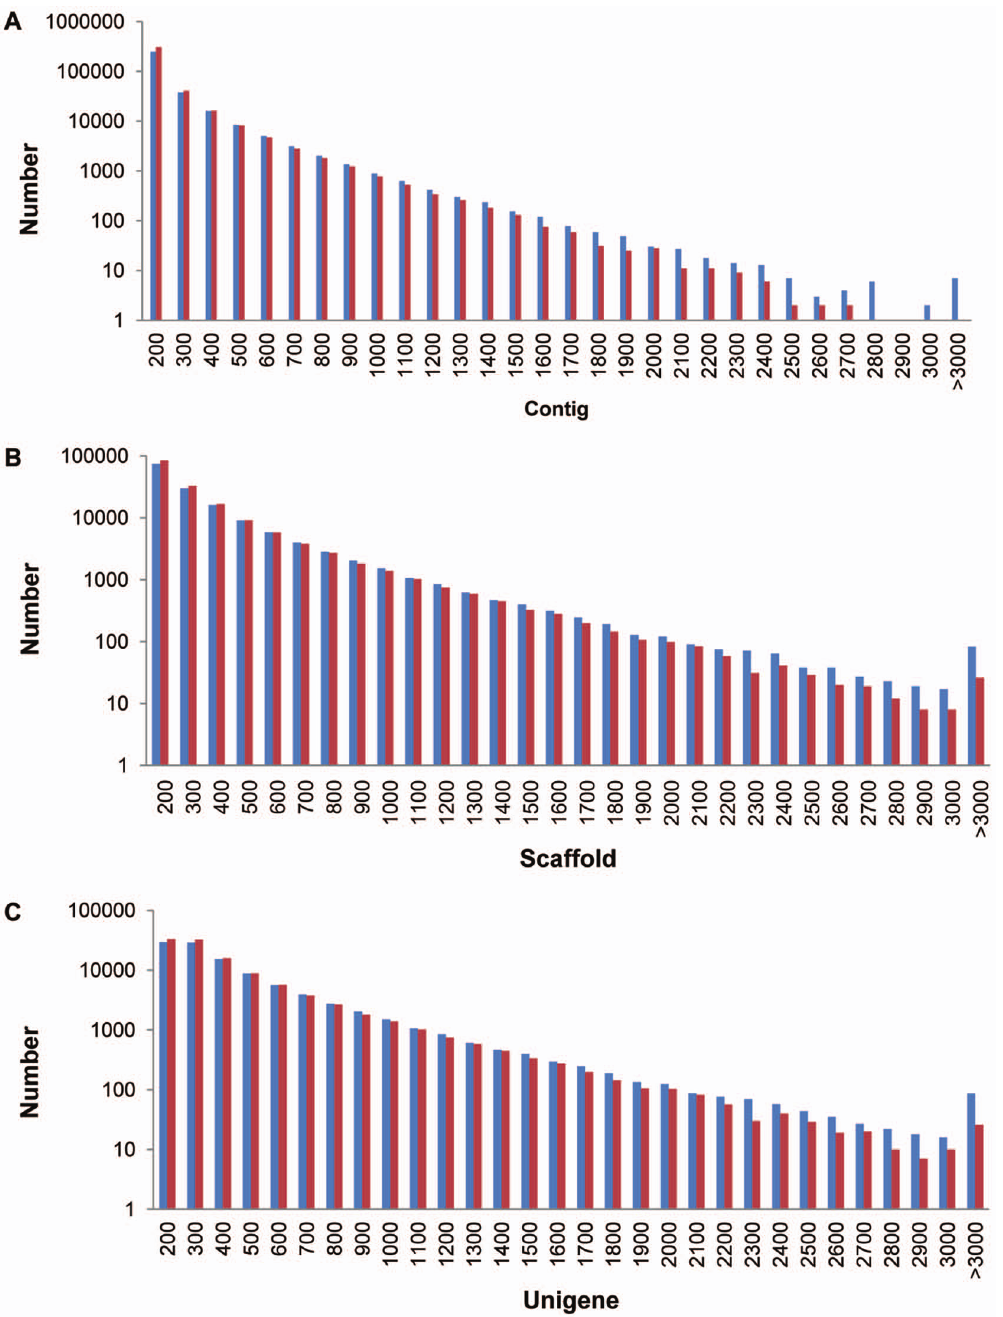
Figure 1. Length distribution of assembled sequences. A, Length distribution of contigs; B, Length distribution of scaffolds; C, Length distribution of unigenes. Samples were derived from: cotyledon (blue), and embryo axis